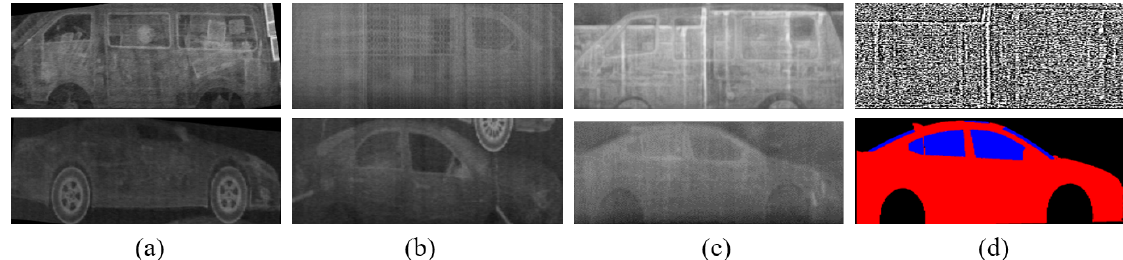
Figure 14. The classification method trained with only the real BSX images can correctly classify samples in ( a ), but failed to estimate the class labels for samples in ( b ), which are correctly classified after data augmentation. Column ( c ) shows synthetic images generated by using the proposed method with edited inputs shown in ( d ) during data augmentation. The top and bottom samples belong to class 6 (the texture map is edited by drawing random white lines to simulate severely occluded samples) and class 1 (the label image is edited to omit the wheels), respectively.